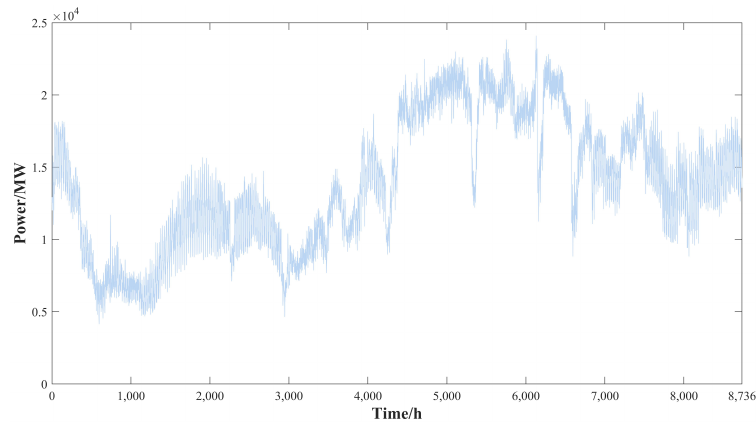
Figure 7. The annual load curve.